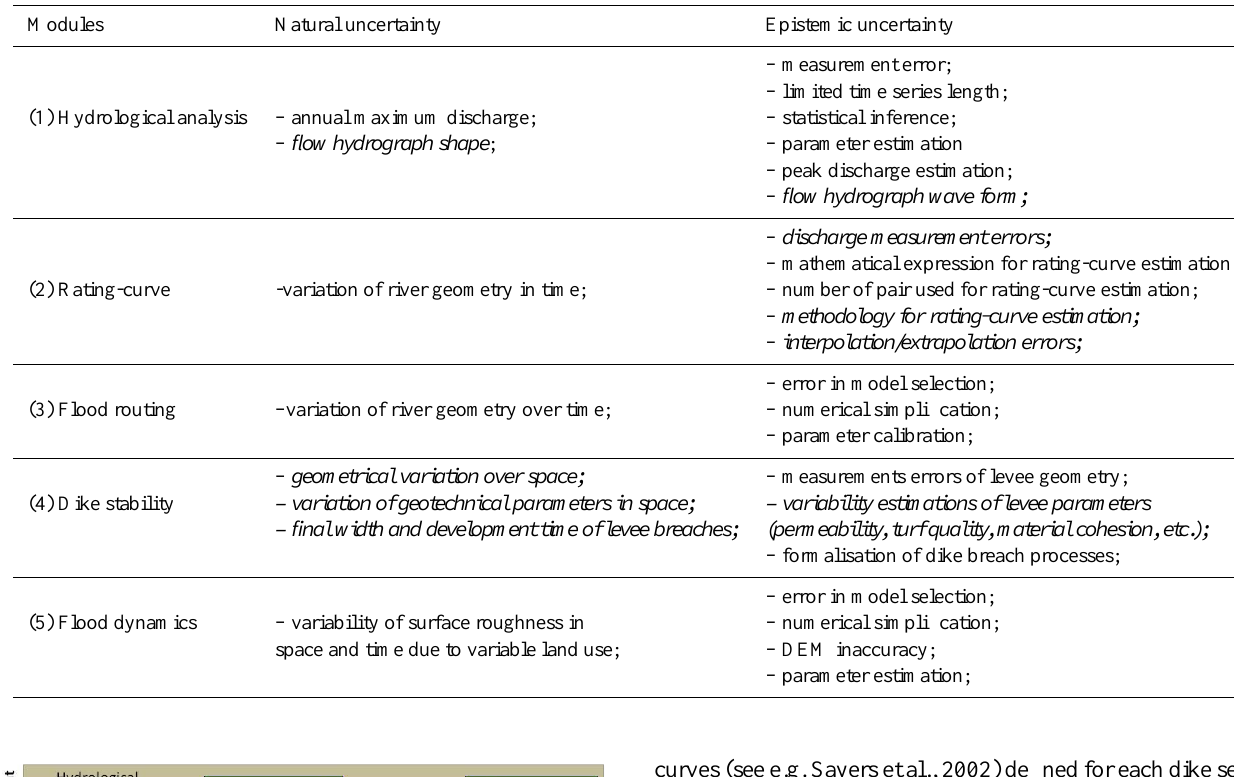
Table 1. Sources of uncertainty in flood hazard mapping grouped into natural and epistemic uncertainty (adapted from Apel et al., 2004); sources in italic are directly considered into the presented analysis.